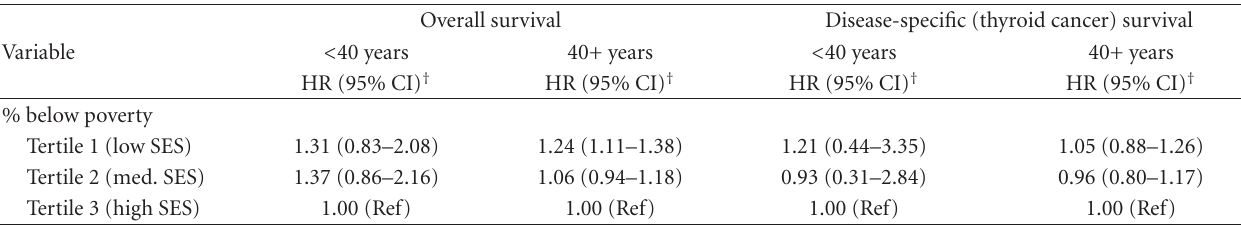
Table 3: Multivariate Cox PH regression analyses 1992–2009 (SEER 12 ∗ ): overall and disease-specific survival by age group ‡ . Overall